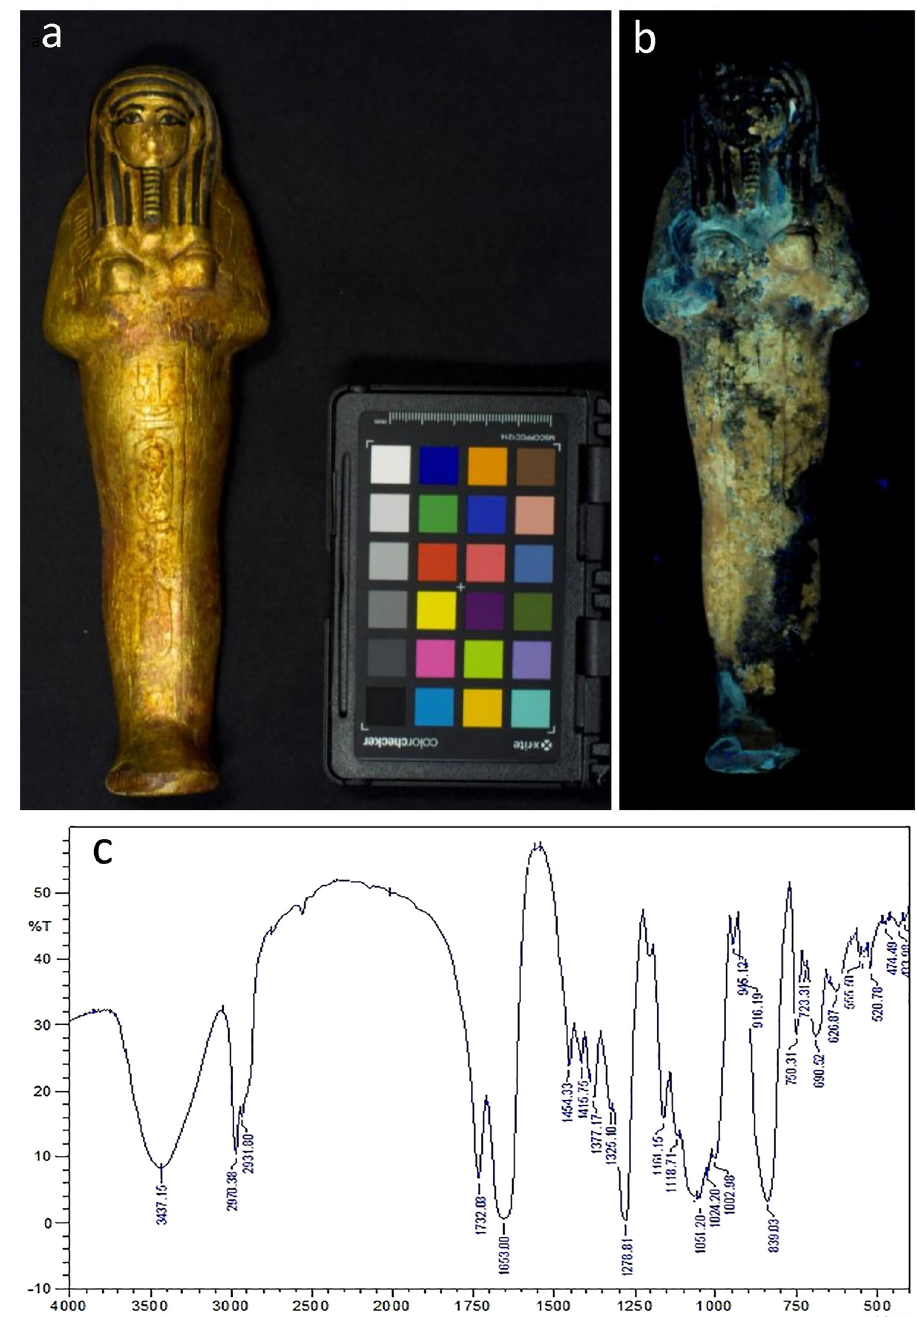
Figure 9: Analytical characterization of the previous consolidation material on the outer surface of Object GEM 3452: ( a ) visible image; ( b ) UV luminescence image; and ( c ) FTIR spectrum of sample